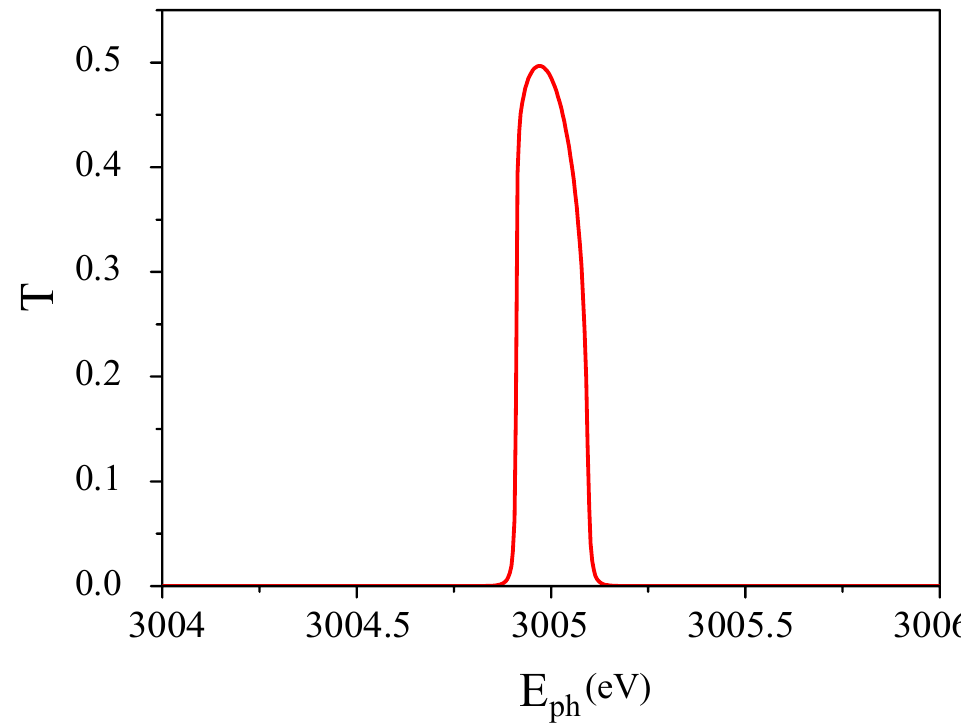
Figure 8. Transfer function of an optical line made by three diamond mirrors and one beam splitter vs. the photon